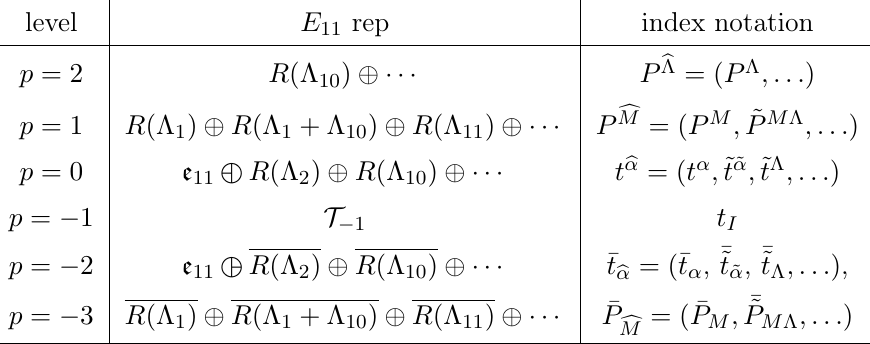
Table 1 . E 11 representations arising at level (cid:0) 3 (cid:20) p (cid:20) 2 elements of the tensor hierarchy